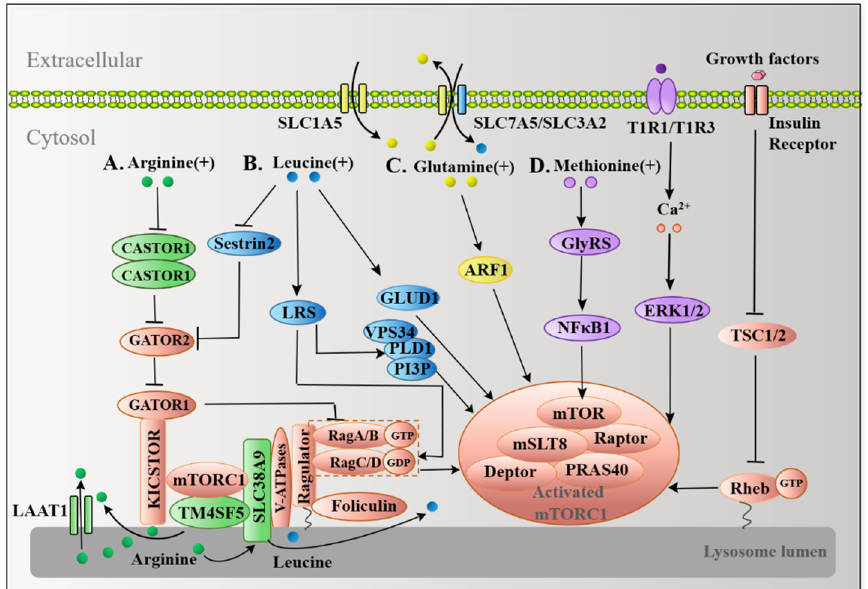
Figure 3. The mTORC1 mediates signal transduction of functional amino acids regulating autophagy; mTORC1 is an intracellular signal transfer station for amino acid regulation of mTORC1-dependent autophagy. ( A ) CASTOR1 senses and binds to arginine, which promotes the translocation and activation of mTORC1 to the lysosomes. SLC38A9 senses arginine in lysosomes and is required for the transfer of leucine out of lysosomes to activate mTORC1. The TM4SF5-mTORC1-SLC38A9 complex, together with LAAT1, facilitates the transfer of arginine out of lysosome. ( B ) Sestrin2 senses leucine in a manner similar to CASTOR1. LRS activates mTORC1 by activating RagGTPase or PLD1. The leucine metabolite acetyl-CoA acetylates the Raptor at K1097 via EP300. GLUD1 also contributes to the regulation of autophagy by leucine. ( C ) Arf1 GTPase participates in glutamine-mediated mTORC1 activation. ( D ) Methionine promotes the activation of GlyRS and activates NF κ B1 to elevate the expression of mTORC1. T1R1/T1R3 senses extracellular methionine to stimulate ERK1/2 activation by enhancing the Ca 2+ concentration and then activates mTORC1.